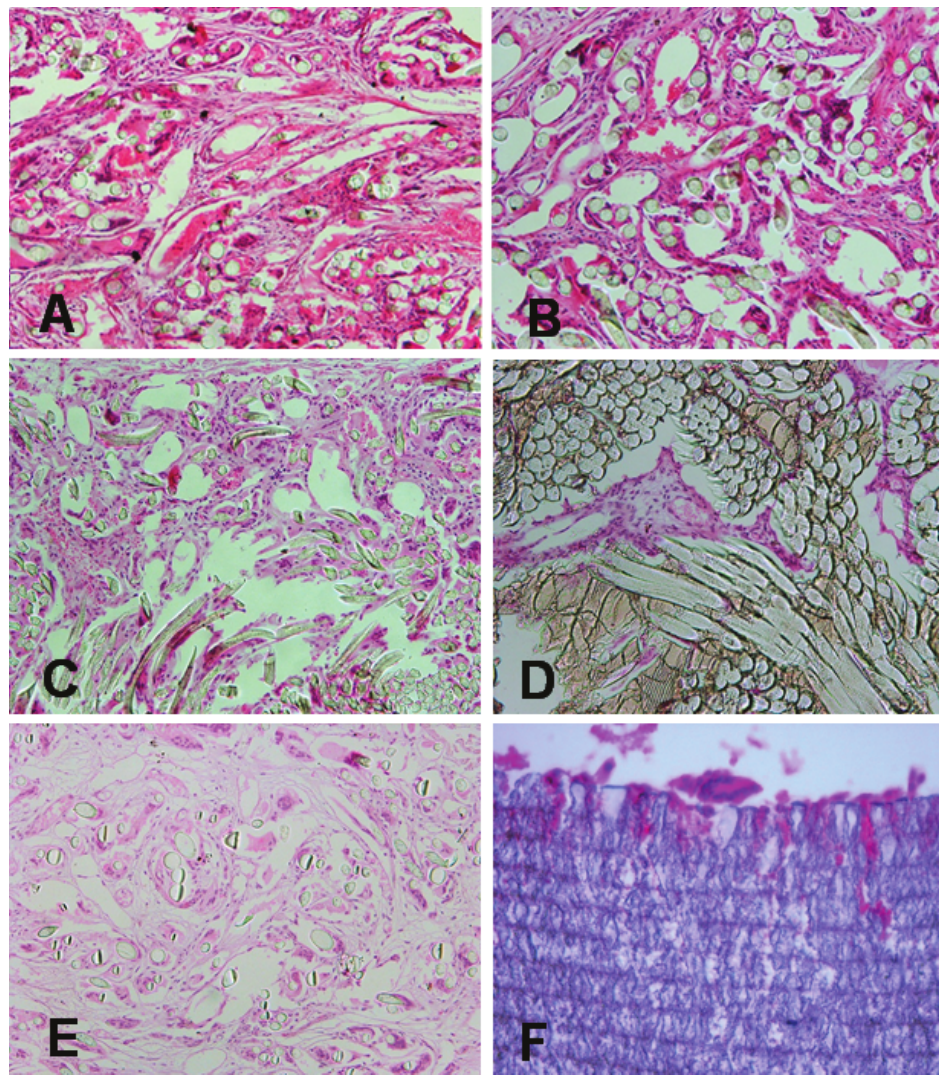
Figure 2. Representative illustrations of fibrovascular ingrowth in various materials. Note the presence of an intense fibrovascular ingrowth into the center of the materials #1 (A) and #3 (B). Materials #2 (C), #4 (D), and #5 (E) revealed a moderate fibrovascular ingrowth up to the paracentral parts of each material. No fibrovascular penetration was noted into material #6 (F). A foreign-body type granulomatous reaction is evident within materials #1 to #5 and around material #6 (H&E, magnification 200 × ).